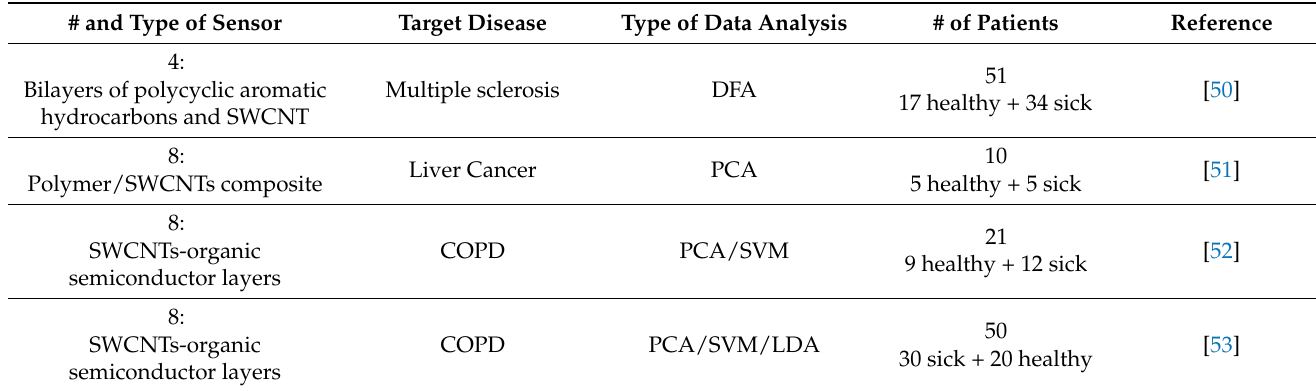
Table 4. Number and type of sensors in the electronic nose based on CNTs, target disease, type of data analysis, and number of patients involved in the study. # =